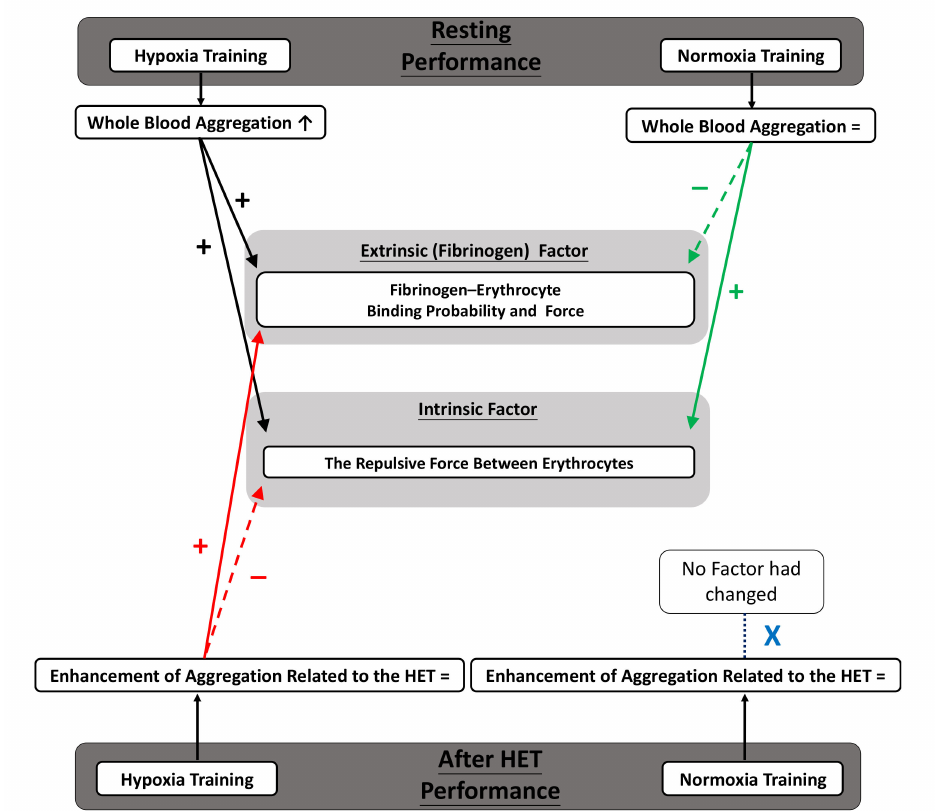
Figure 6. Possible mechanism of the present study. After training, the HET-related aggregation level was not altered in either group; however, after HE, the resting aggregation was significantly augmented via enhancements in both intrinsic and extrinsic response. In contrast to HE, NE elevated the intrinsic aggregability but also diminished the affinity between erythrocytes and fibrinogen. Solid line : enhanced effect; Dashed line : diminished